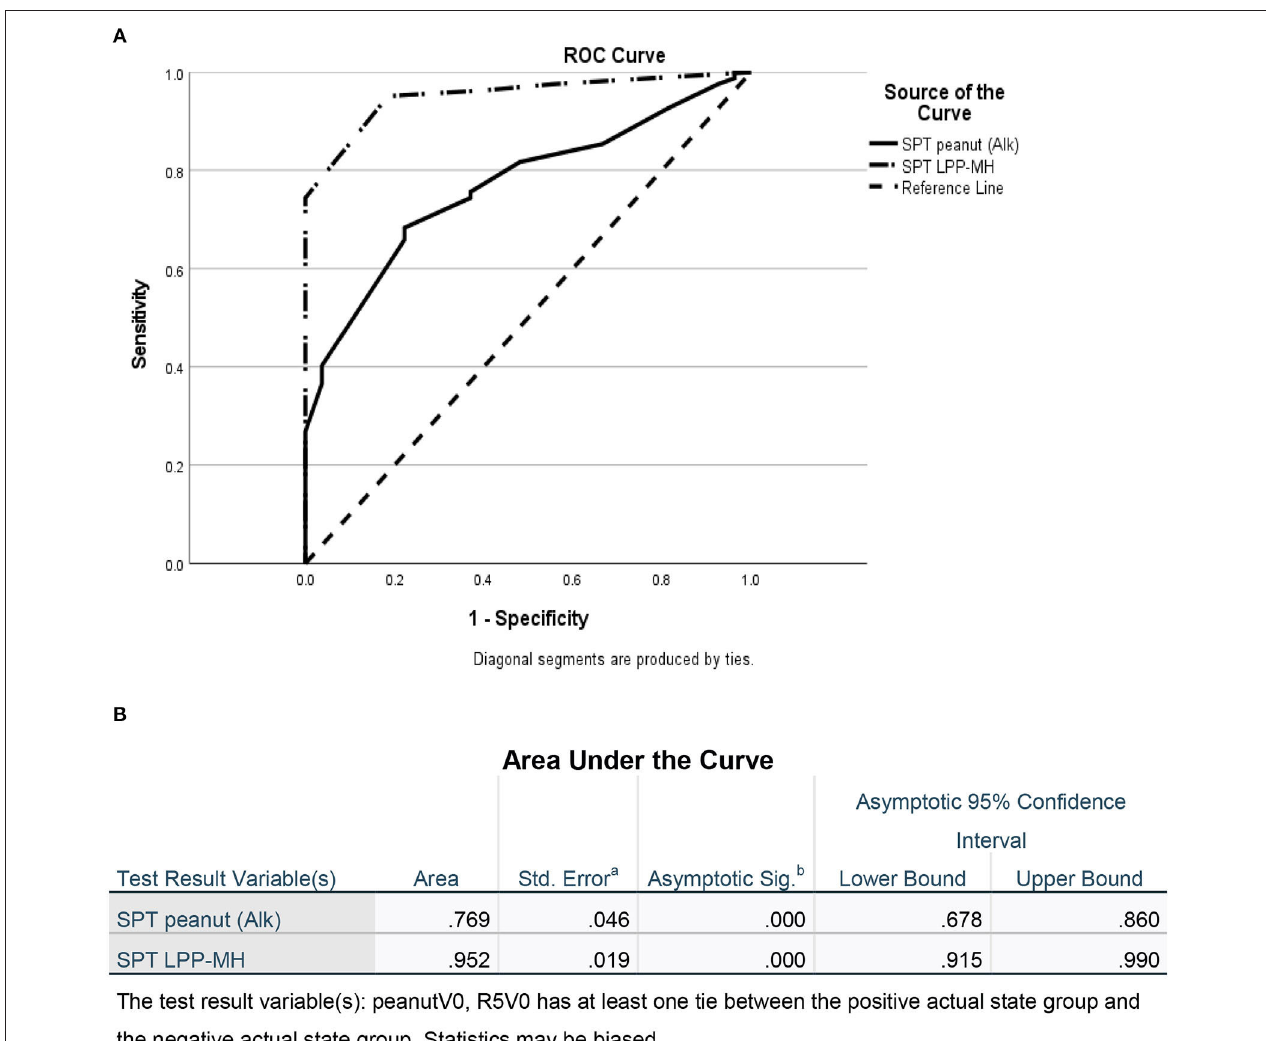
FIGURE 2 | ROC of skin tests with commercial peanut extract and LPP-MH for the diagnosis of Peanut allergy in children. (A) ROC curve and (B) Area under the curve. reintroduce peanuts into their regular diet. For demographic